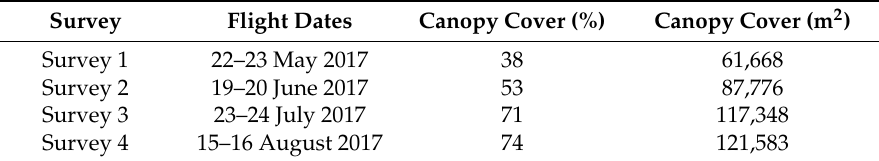
Table 1. A summary of the survey dates and percent cover of Big Springs Creek.